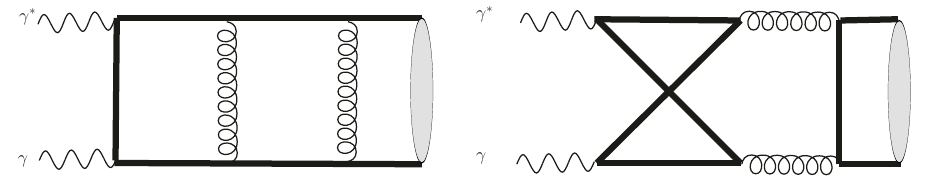
Figure 1 . Typical two-loop Feynman diagrams for CP-even heavy quarkonium